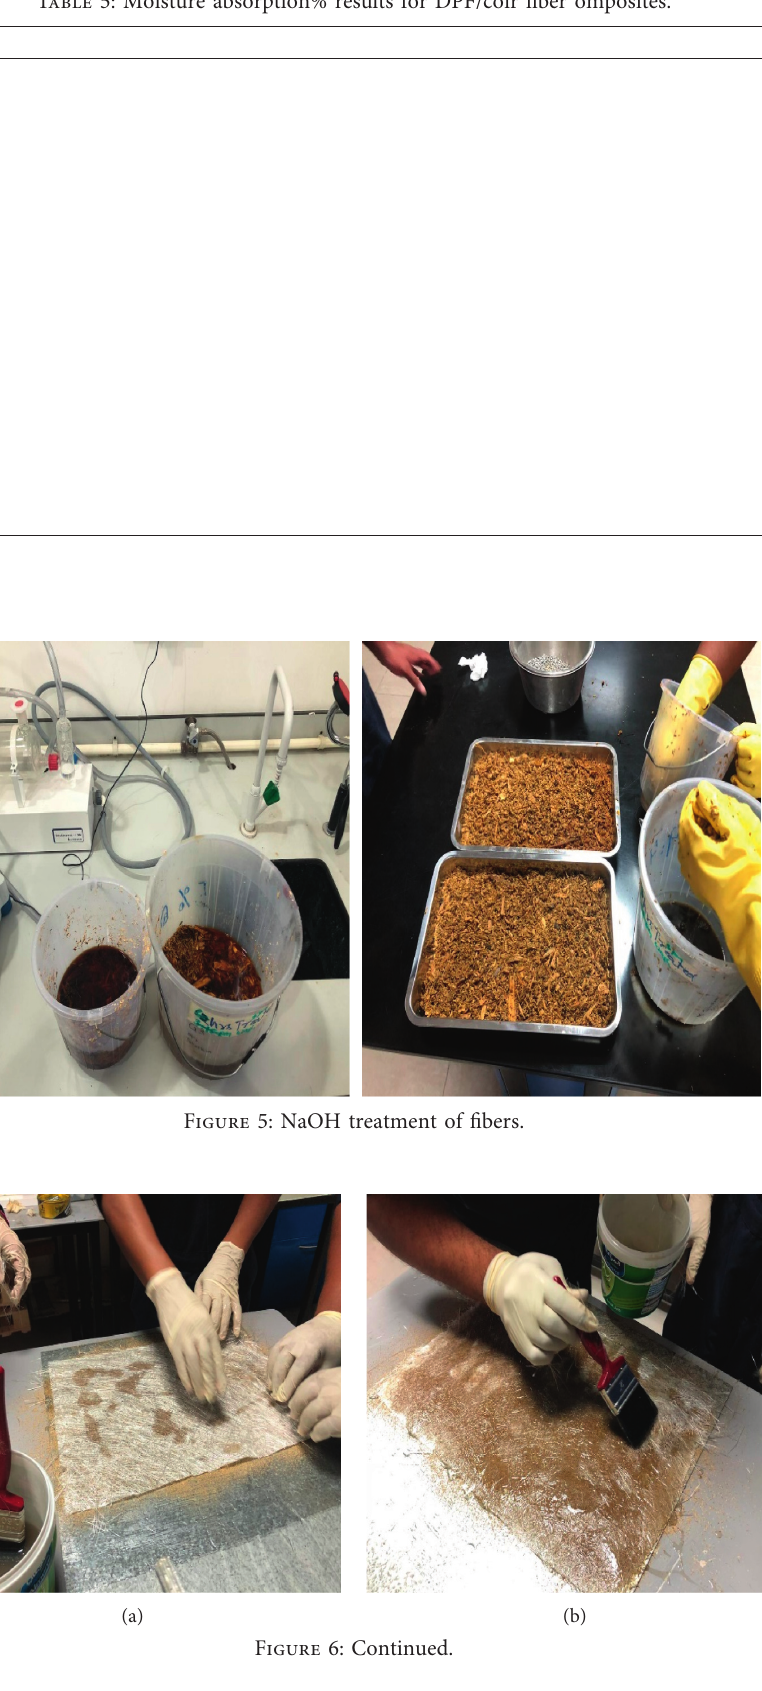
Table 5: Moisture absorption% results for DPF/coir fiber omposites.